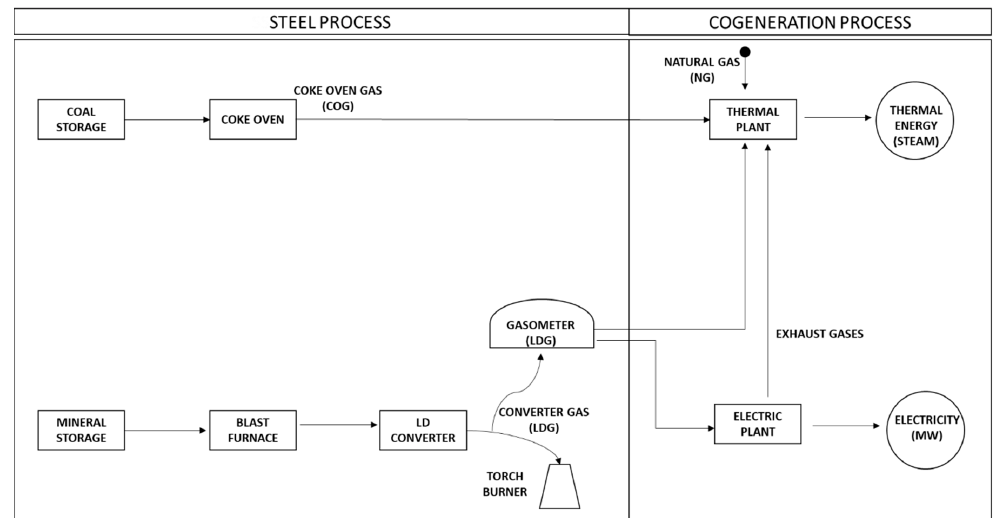
Figure 1. Schematic view of a simple iron and steel cogeneration process.